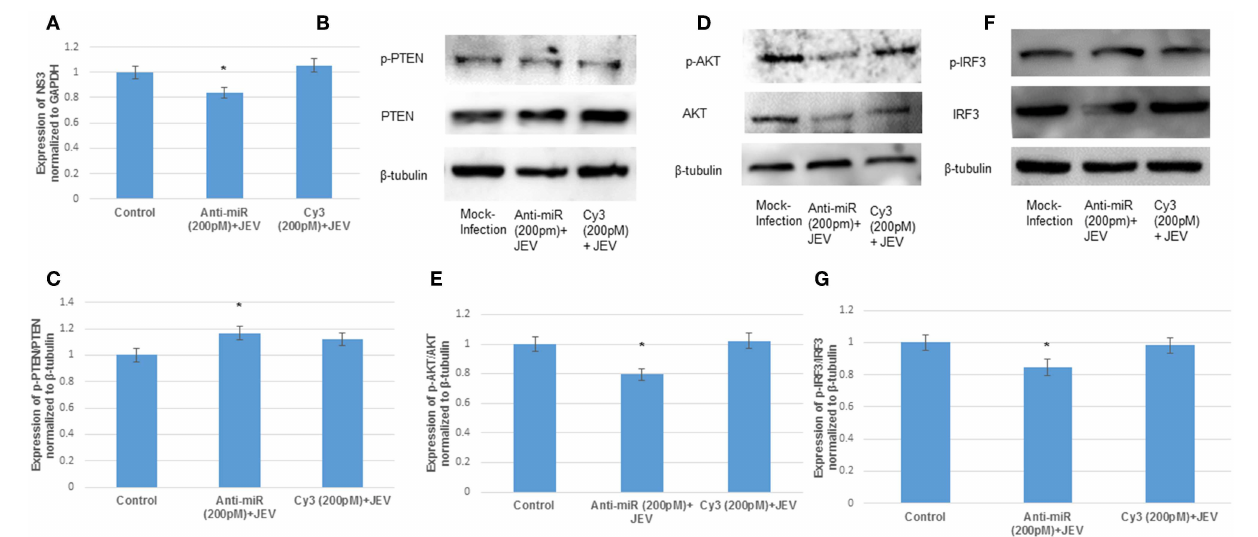
FIGURE 6 | The knockdown of hsa-miR-374b-5p during JEV infection. (A) The qRT-PCR to confirm the JEV infection post transfection. (B) Expression levels of p-PTEN/PTEN rescues up to 1.2-fold during anti-miR transfection post JEV infection. (C) The densitometry plot of p-PTEN/PTEN. (D) The p-AKT/AKT expression suppresses by 20% during anti-miR transfection post JEV infection. (E) The densitometry plot of p-AKT/AKT. (F) The p-IRF3/IRF3 expression suppresses by 20% during knockdown of hsa-miR-374b-5p post JEV infection. (G) Densitometry plot of p-IRF3/IRF3 proteins. The data are shown as mean ± S.E from three independent experiments ( n = 3 ). The fold change is significant where * denotes P < 0.05, ** denotes P < 0.01, *** denotes P < 0.001.